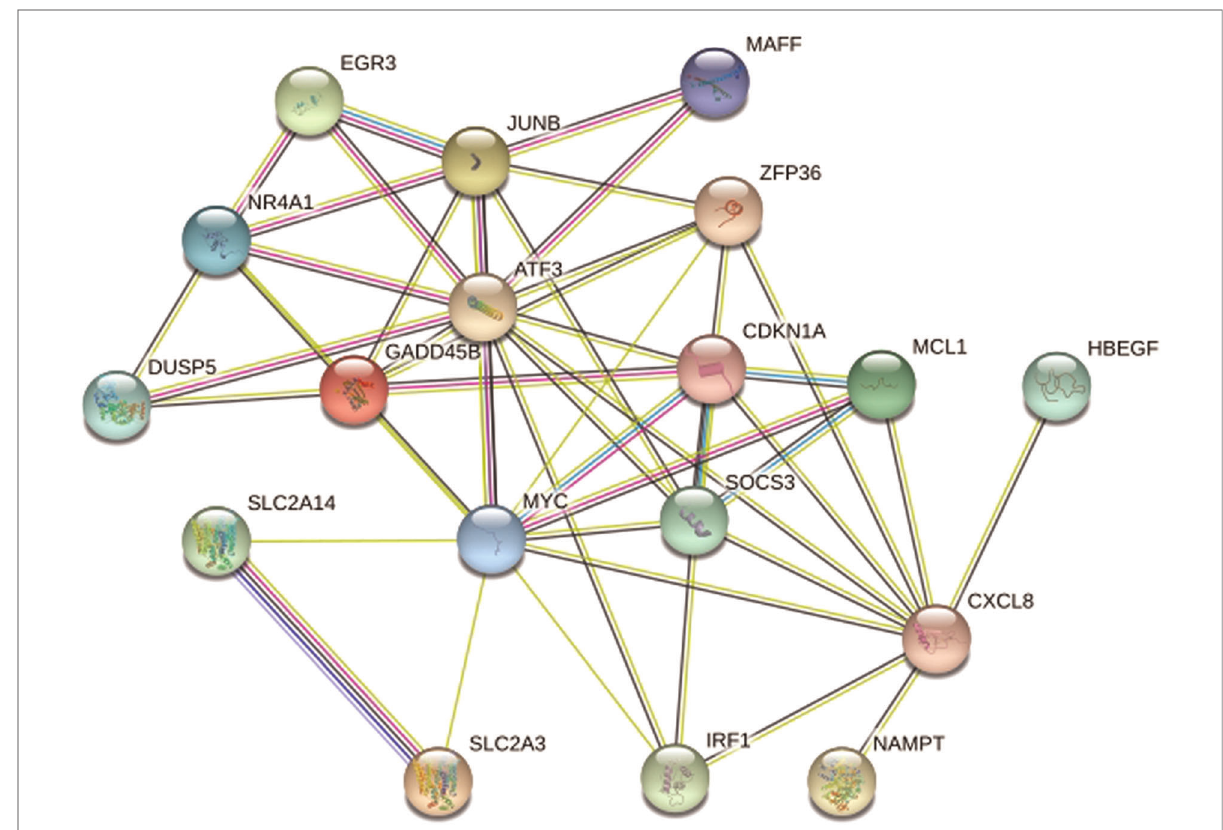
FIGURE 5 Protein protein Interaction Network Diagram. After removed disconnected nodes in the network, only 18 genes remained.They were MCL1 , JUNB , ZFP36 , CDKN1A , NR4A1 , MYC , IRF1 , ATF3 , MAFF , EGR3 , SOCS3 , GADD45B , DUSP5 , CXCL8 , SLC2A14,SLC2A3 , NAMPT and HBEGF